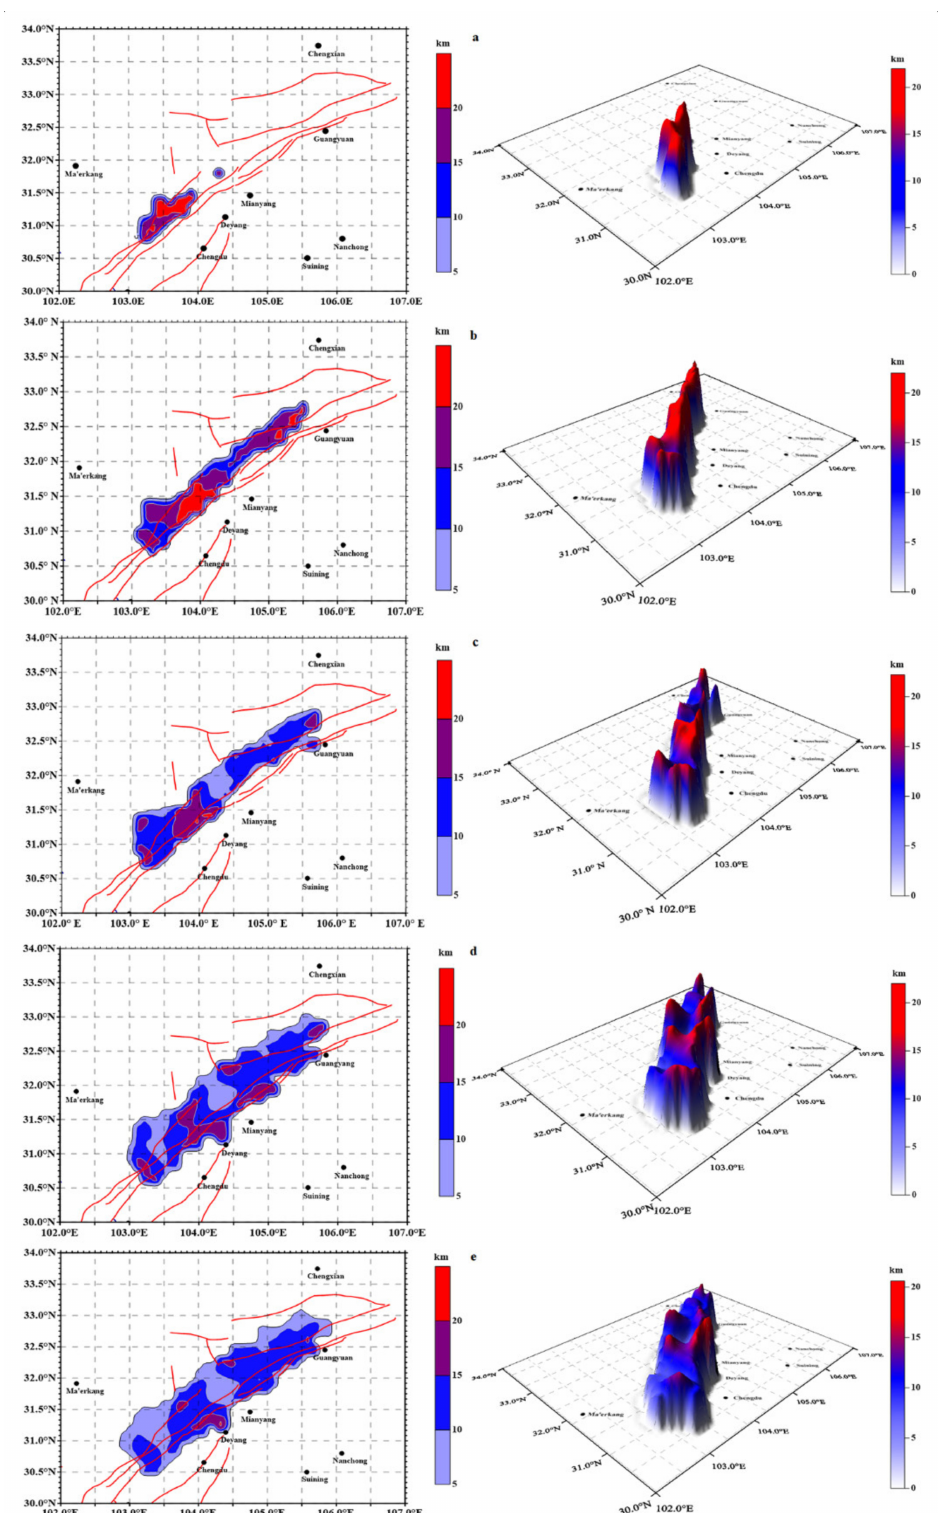
Figure 6. Spatial distribution of the focal depths of the aftershocks following the Wenchuan M S 8.0 earthquake on the fault plane. Red lines represent the locations of faults. ( a ) One day after the mainshock; ( b ) 1 week after the mainshock; ( c ) 1 month after the mainshock; ( d ) 1 year after the mainshock; and ( e ) 3 years after the